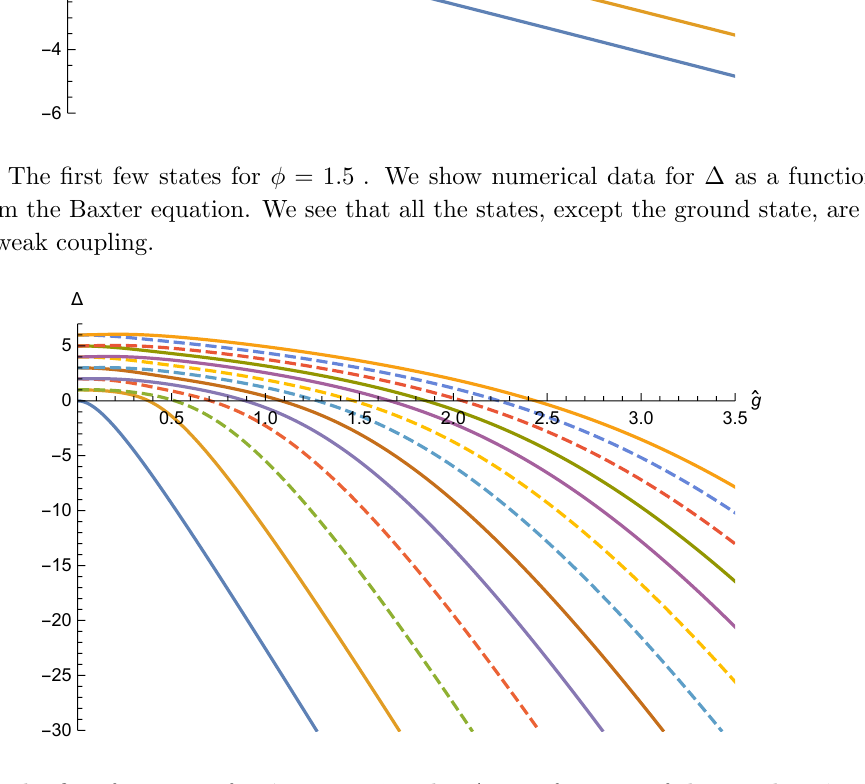
Figure 14 . The (cid:12)rst few states for (cid:30) = 3 : 0 . We plot (cid:1) as a function of the coupling ^ g similarly to (cid:12)gure